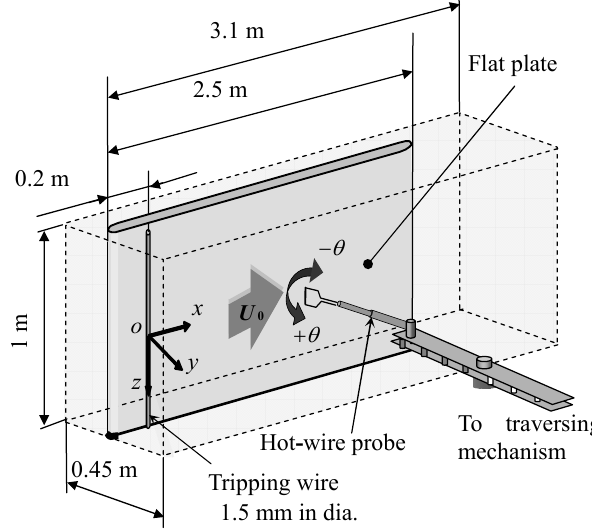
Fig. 5 Schematic diagram of experimental